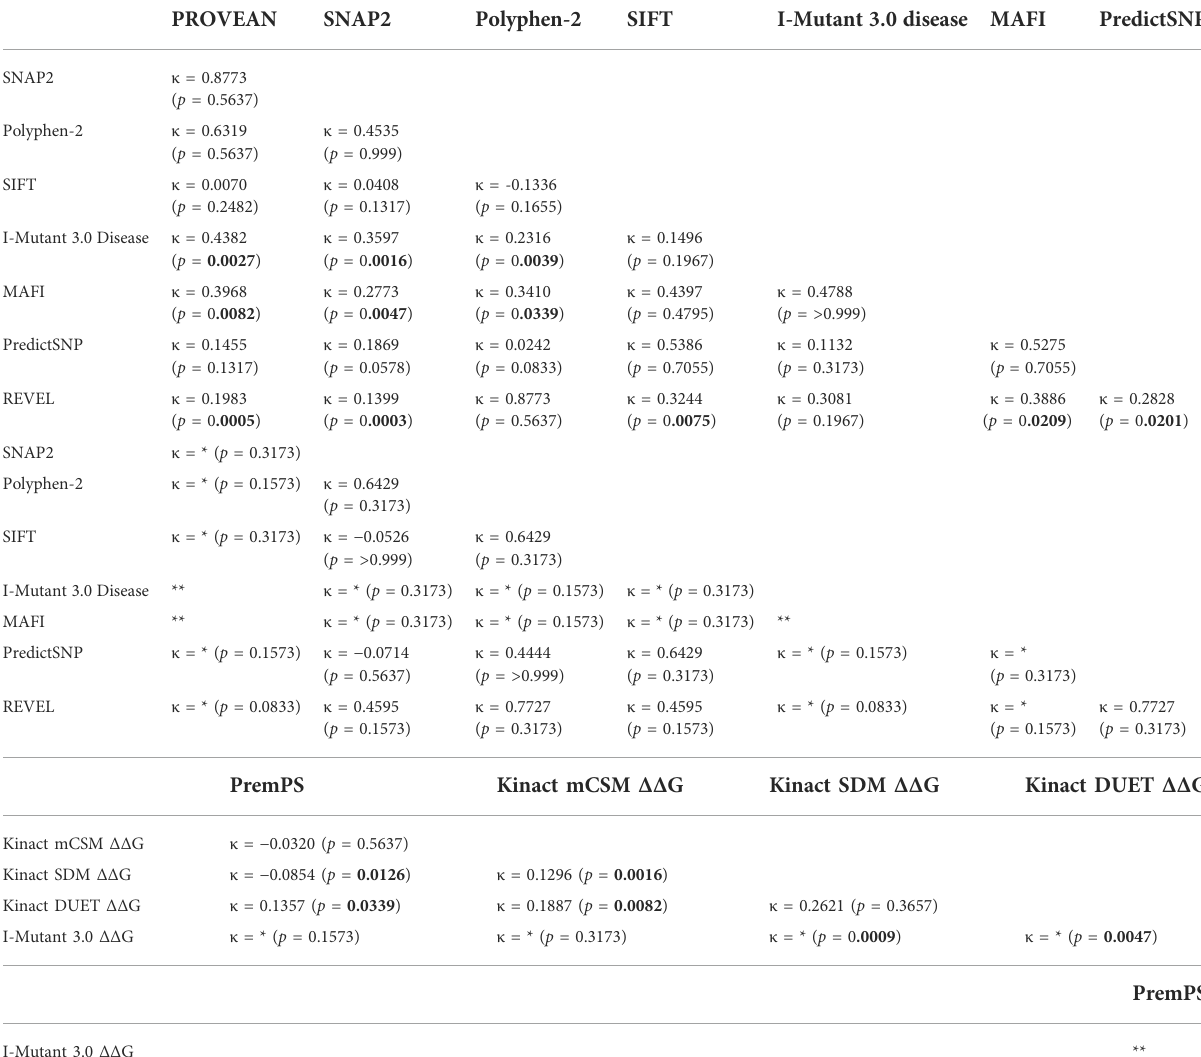
TABLE 6 McNemar ’ s test of categorical values. Each categorical value was coded as either a benign or effect. We calculated percent agreement, the Kappa coef fi cient and performed McNemar ’ s test to determine statistically signi fi cant differences in categorical values. PROVEAN